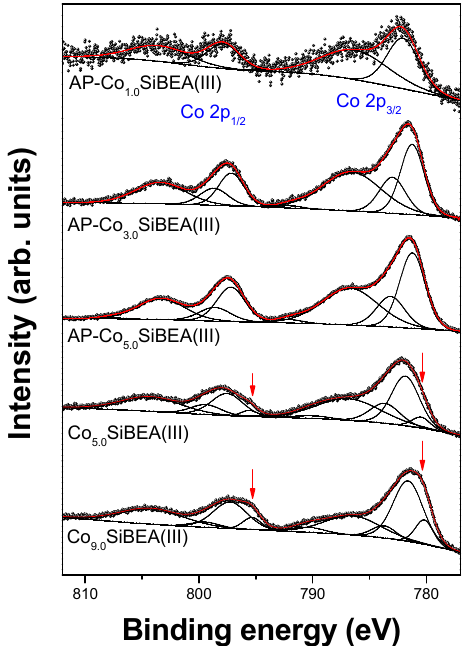
Figure 8. Co 2p XPS spectra of Co x SiBEA (pH = 3.0–9.0). Red arrows mark a low-BE component which is not seen in as received samples.